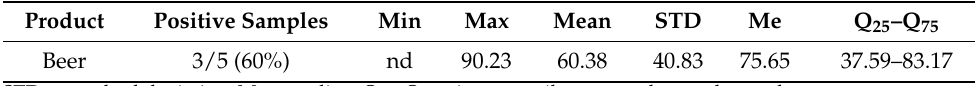
Table 3. The level of gluten contamination of beers containing barley malt